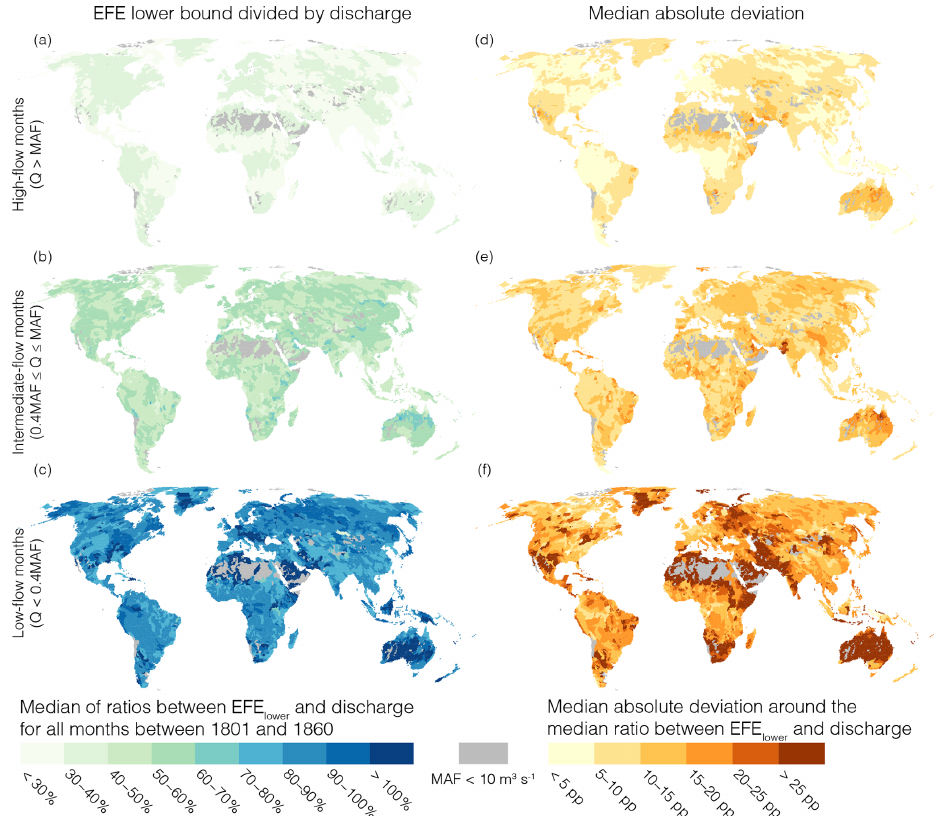
Figure A2. Comparison between the environmental flow envelope (EFE) lower bound and pre-industrial discharge. Q stands for monthly discharge and MAF for mean annual flow. Here, for each global hydrological model (GHM) and month, we took the pre-industrial median discharge over all general circulation models (GCMs) and divided the EFE lower bound with it, yielding a total of 2880 ratios for each sub-basin (4 GHMs × 60 years × 12 months). Then, for each season and across all GHMs, we took the median of the resulting EFE lower /Q ratios (a–c) and computed the median absolute deviation around this value (d–f) . Some EFE lower bound values exceed the median low-flow season discharge owing to high variation in pre-industrial discharge affecting the distribution of environmental flow requirements (EFRs), from which the EFE lower bound is drawn (see Sect. 2.2). Moreover, the spread of ratios between EFE lower bound and low-flow season monthly discharge is relatively high, further indicating high variability in low-flow season discharge modelled by GHMs during the pre- industrial